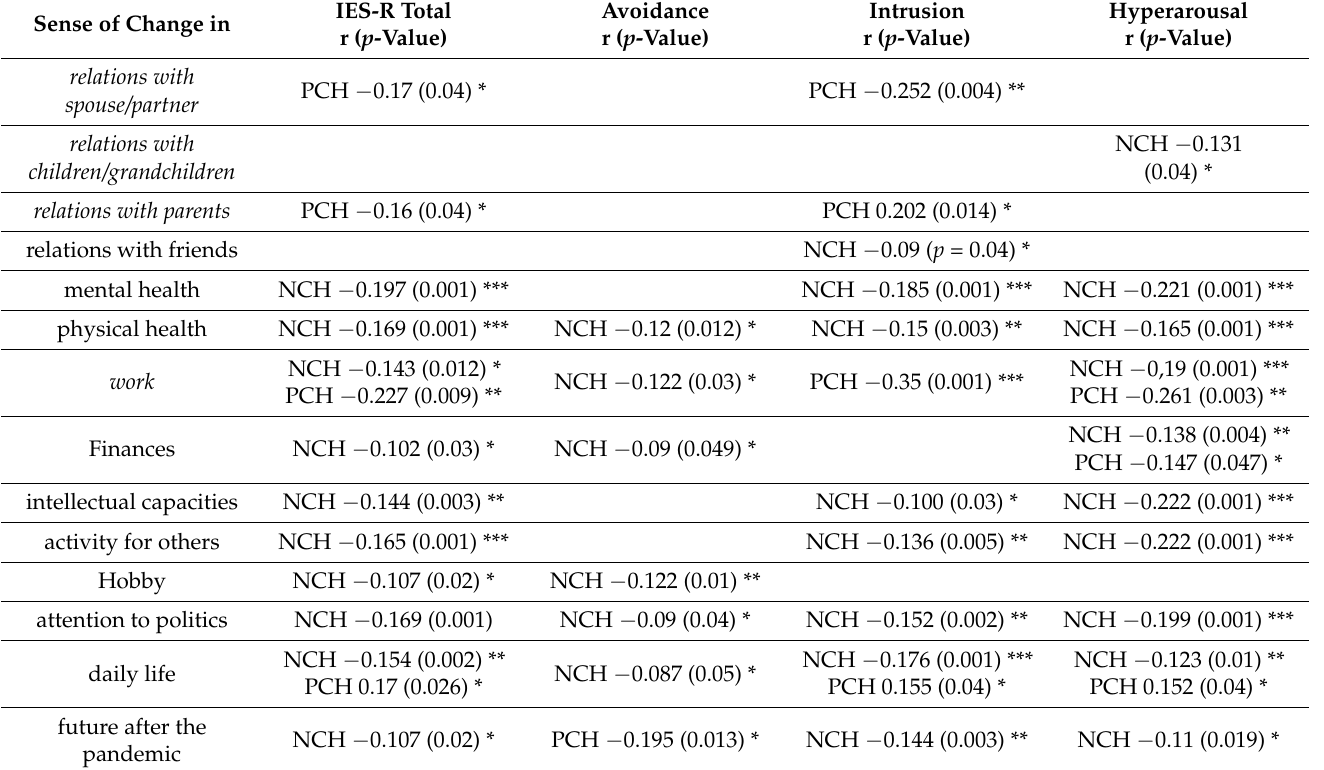
Table 5. Correlations between the scores of the Impact of Event Scale: Revised (IES-R) and Sense of Life Changes Questionnaire (COVID-19 SLCHQ) in the groups with a negative (NCH) and positive (PCH) sense of changes.